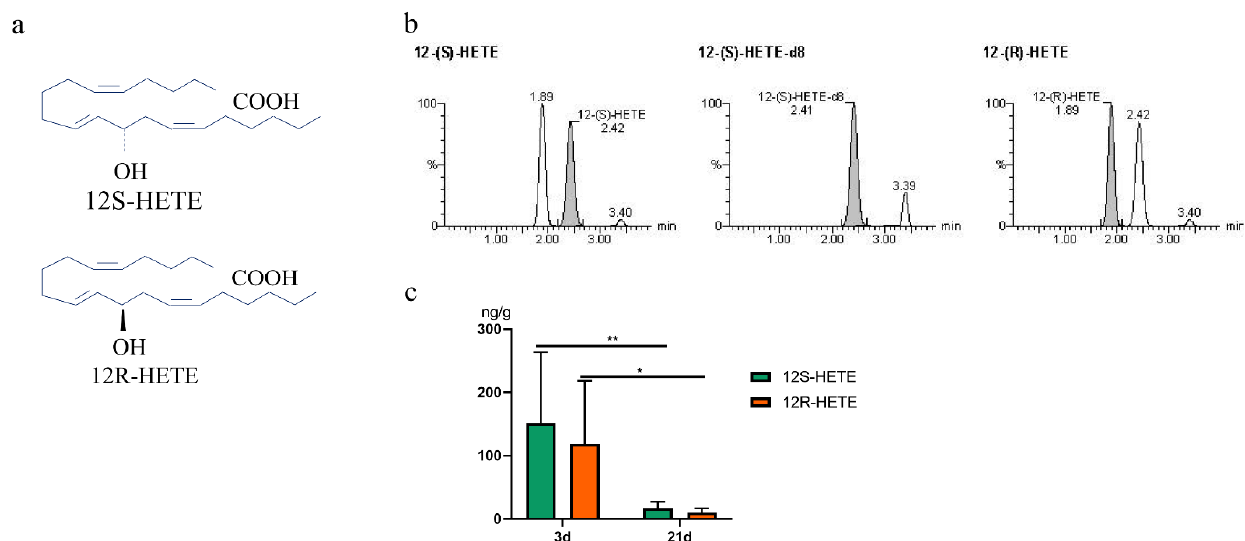
Figure 5. Chiral LC-MS/MS analysis of 12-HETE in feces of suckling piglets ( n = 10). ( a ) Chemical structure diagram of 12(S)-HETE and 12(R)-HETE. ( b ) Selected reaction monitoring (SRM) chroma- tograms demonstrating the resolution of 12(S)- and12(R)-HETE in feces of suckling piglets at birth day 3 and day 21( n = 9). ( c ) the quantitative content of 12(S)- and12(R)-HETE in feces at 3d and 21d postnatally, values are the mean ± SD, n = 10. Statistical analysis was performed by Tukey tests, * p < 0.05, ** p < 0.01. Table 3. Chiral LC-MS/MS analysis of 12(S)and 12(R)-HETE enantiomers during suckling period.